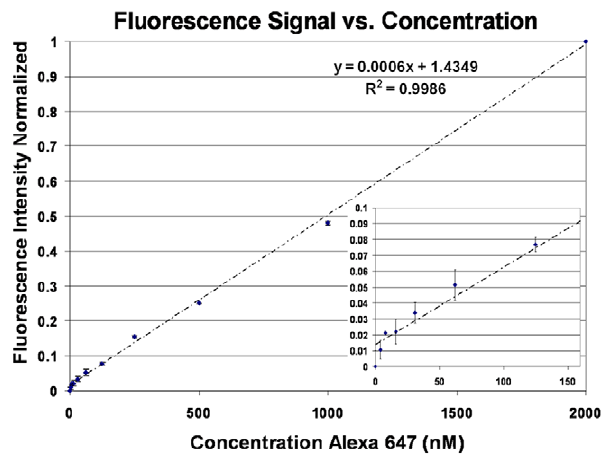
Figure 4. Fluorescence System Calibration. Normalized fluores- cence response for different fluorophore concentrations in our instrument. Background subtraction using a control channel on the same flowcell was performed. Inset shows the system response at the lower end of the dilution range.